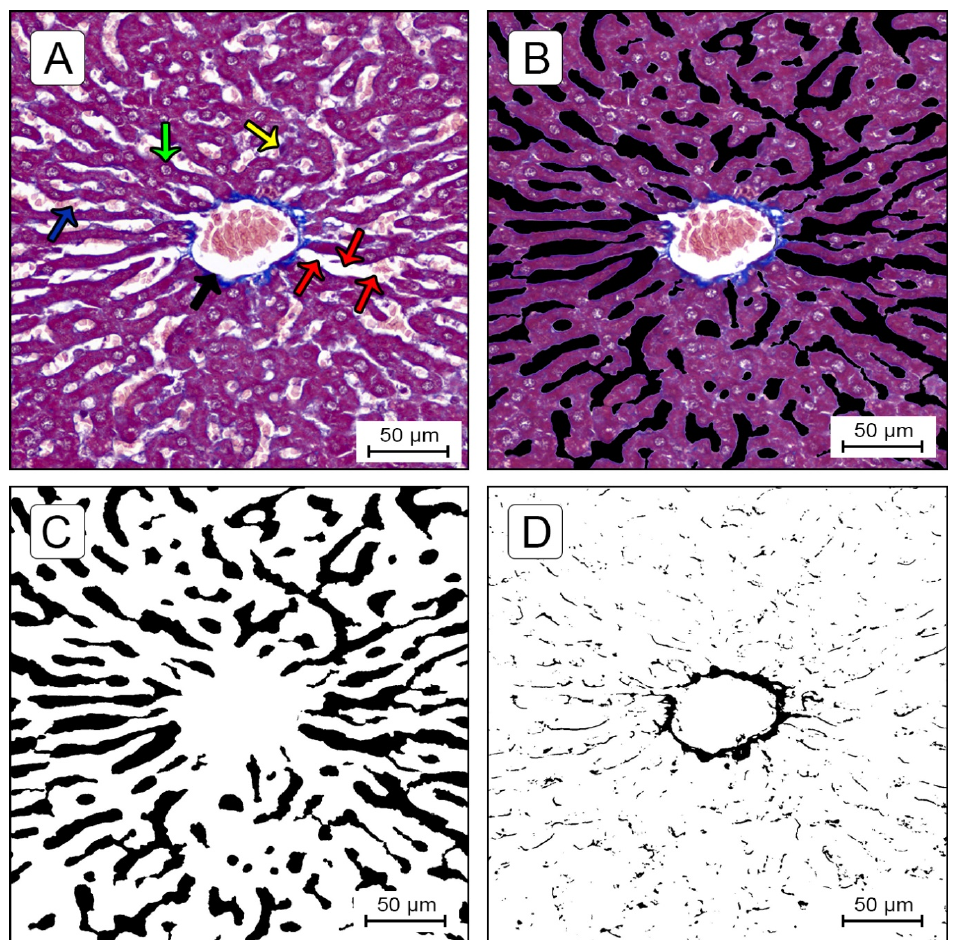
Figure 7. ( A ). TM-stained specimen of liver tissue; centrilobular vein (black arrow); sinusoids (red arrows); hepatocyte (green arrow); Kupffer cell (yellow arrow); red blood cells in sinusoidal lumen (blue arrow). ( B ) Manually extracted sinusoidal lumen image using Adobe ® Photoshop ® . ( C ) Sinusoidal mask image using ImageJ ® ; black pixels indicate the sinusoidal lumen and white pixels indicate the trabecular structures and central vein. ( D ) Fibrotic zone mask image using ImageJ ® ; the black pixels indicate fibrotic zones.